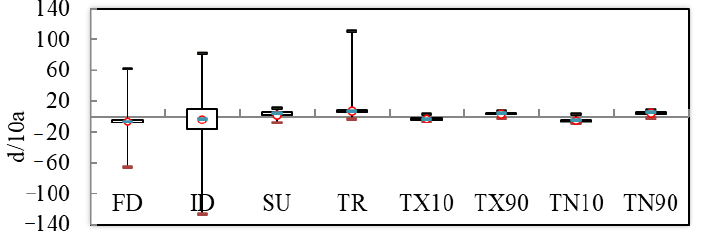
Figure 11. Box-plot of relative indices and absolute indices. At the top of the box-framed figure is the lower quartile value of the sequence, and at the bottom is the upper quartile value. Unit: FD, ID, SU, TR, TX10, RR1, TX90, TN10, TN90 (d/10a).